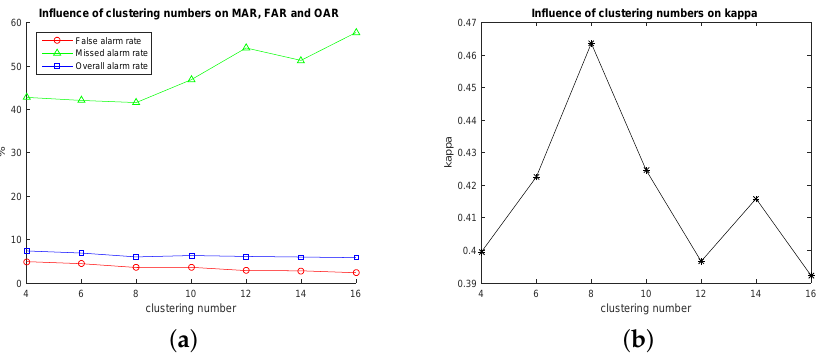
Figure 4. The influence of different clustering numbers. The clustering numbers range from 2–4 to 2–16. ( a ) Influence of clustering numbers on false alarm rate (FAR), missed alarm rate (MAR) and overall alarm rate (OAR); ( b ) influence of clustering numbers on kappa